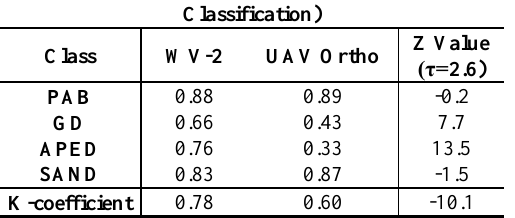
Table 2. Confusion matrix concerning the pixel-based classification: Worldview-2 data (a) and UAV Orthophoto (b). highest concentration of wrongly classified pixels is located along class boundaries.